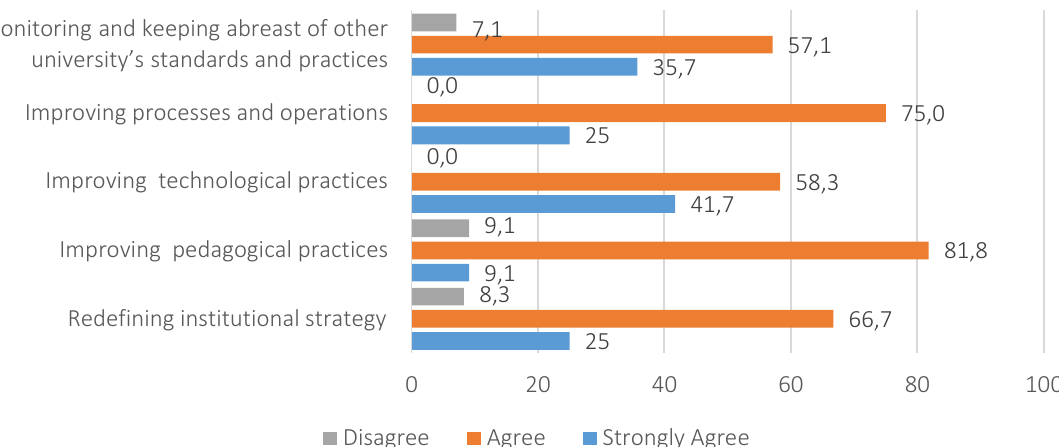
Figure 2 represents the regularity of KM pres- entations to university authorities. More than a